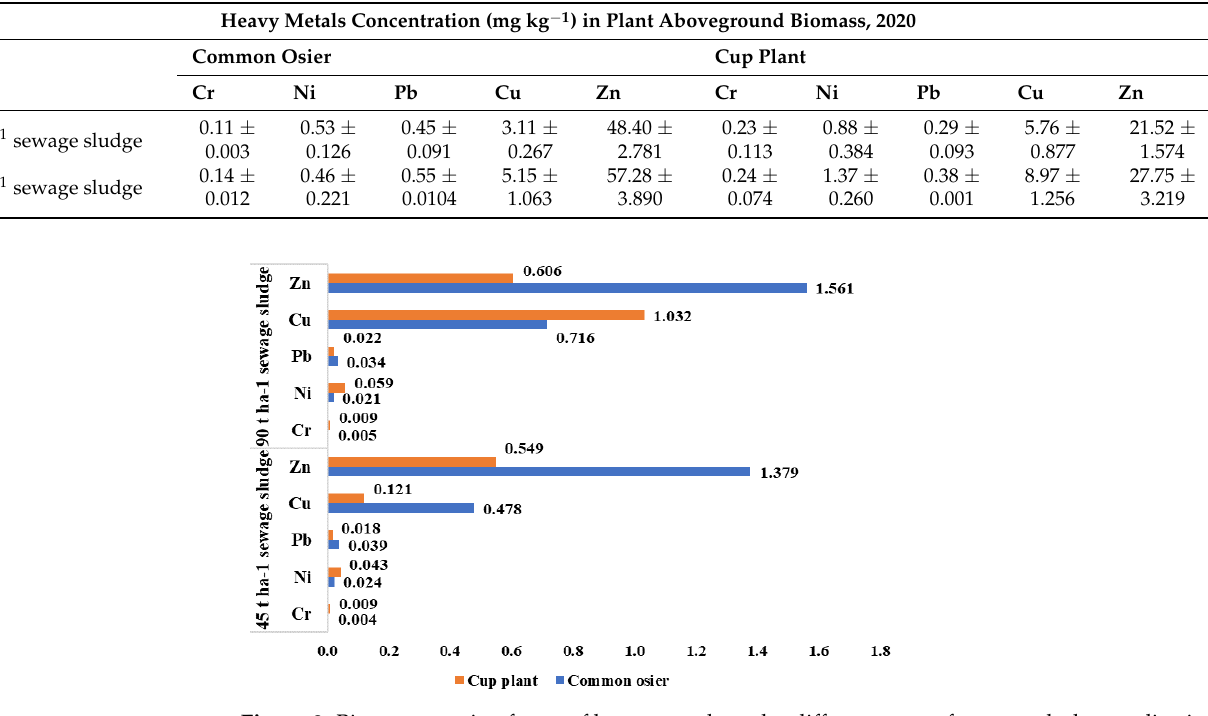
Table 6. Heavy metals concentration in plant aboveground biomass under different contamination with sewage sludge levels by growing different energy plants.